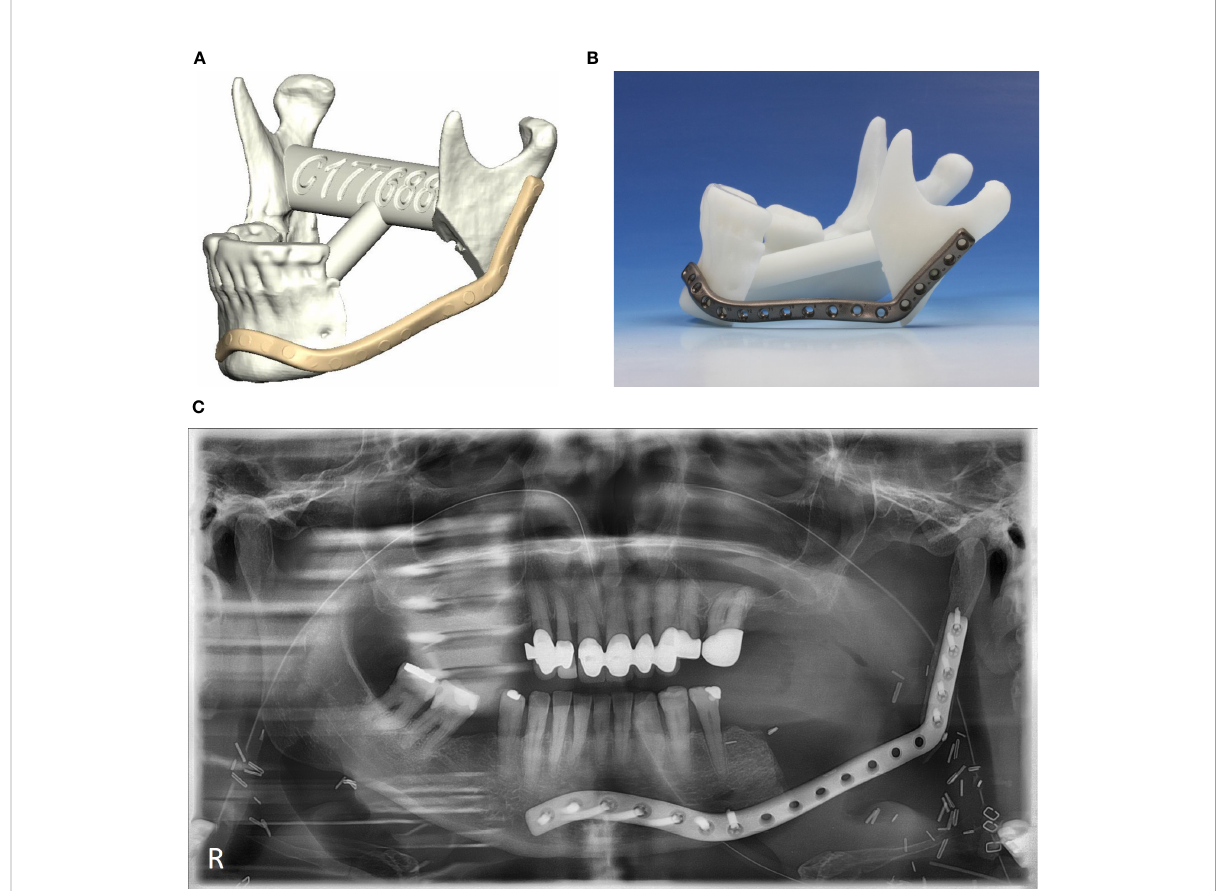
FIGURE 1 Non-complex patient-speci fi c implants. (A) Digital planning, (B) patient-speci fi c implant on plastic model, (C) postoperative